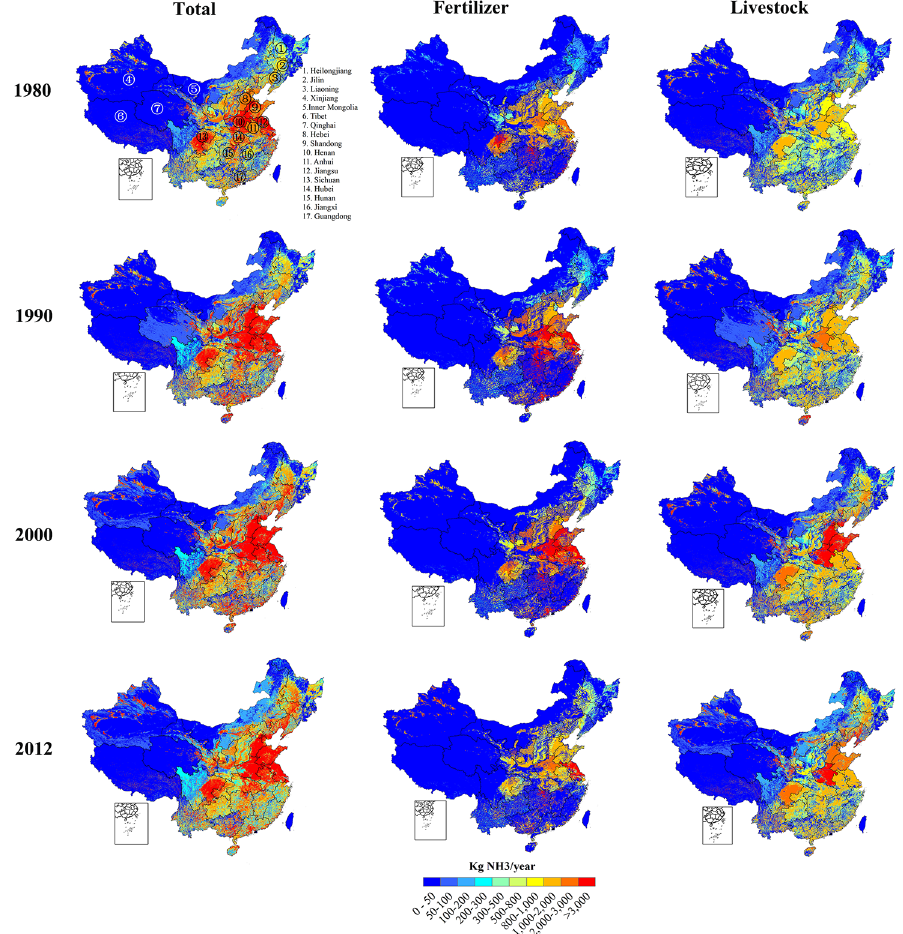
Figure 5. Spatial distribution of NH 3 emissions in China in 1980, 1990, 2000, and 2012 (from left to right: total emissions, synthetic fertilizer emissions, and livestock